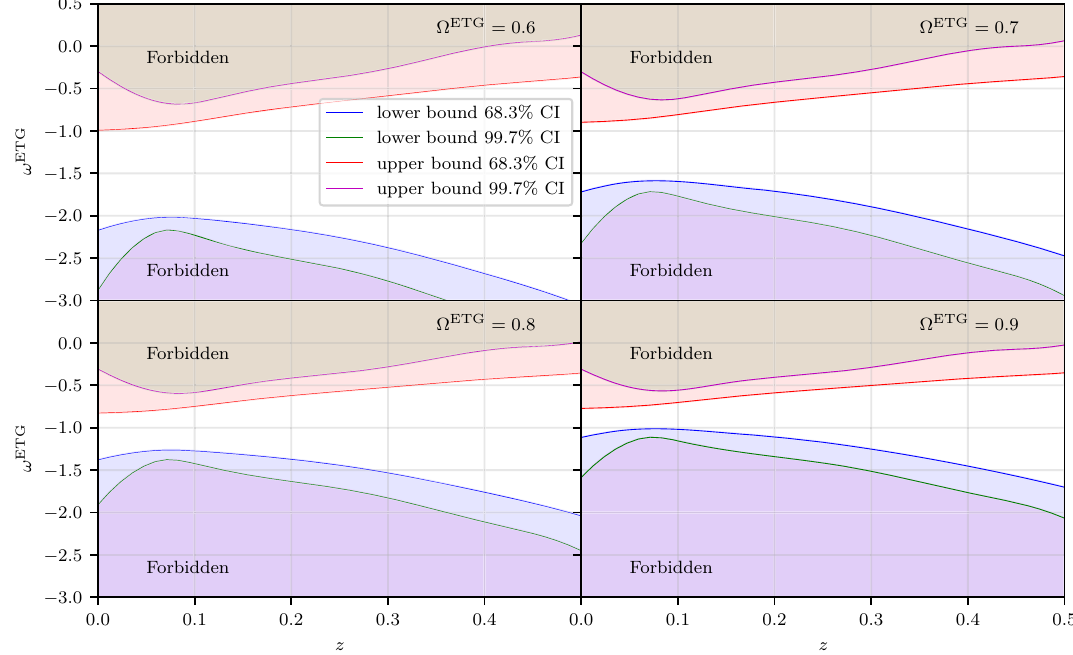
Fig. 5 The one and three sigma bounds (68.3% and 99.7% CIs) on ω ETG at the redshift interval [ 0 , 0 . 5 ] obtained from the reconstructed q ( z ) by using SNe Ia + BAO + H ( z ) data. The four plots show the effect of changing the value of Ω ETG on these bounds. These results correspond to the = flat case Ω 0 k